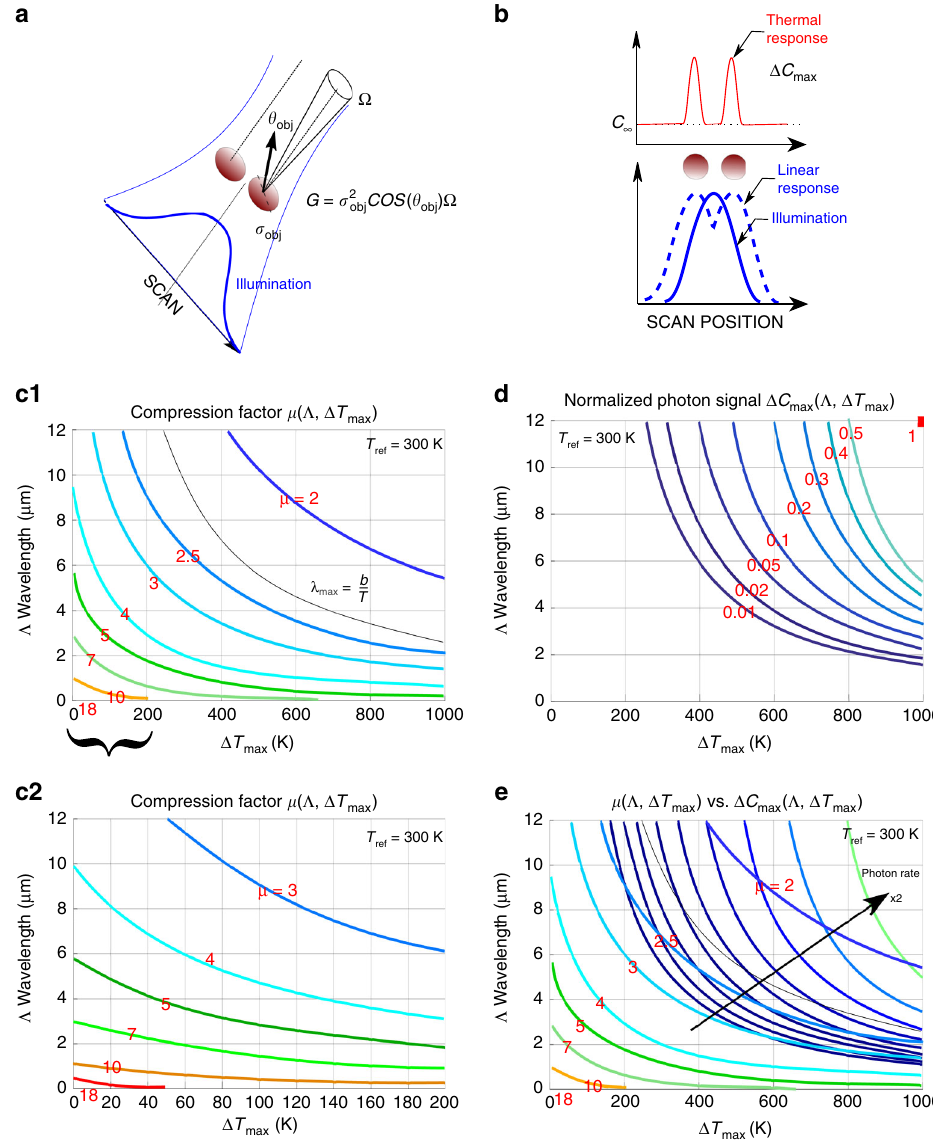
Fig. 3 Scanning illumination, thermal response, and compression factor. a Two supposedly planar objects are illuminated by a focused beam with an excitation psf larger than their linear size σ and the distance between them. Each object has an obliquity angle θ obj G ¼ σ 2 cos ð θ obj Þ Ω . b The Planck thermal photon signal C max produced by the scanning illumination is compared to the linear response. C ref represents the obj background thermal photon signal. c1 , c2 The 2D plot of the psf compression factor μ as a function of the maximum heating Δ T wavelength Λ . μ is computed for a Gaussian illumination psf as the ratio of the FWHM of the illumination psf and the thermal radiation psf, and shown for (cid:6) 1000 K ( c1 ) and 0 K (cid:6) Δ T (cid:6) 200 K ( c2 ). d Biparametric representation of the signal Δ C 0 K (cid:6) Δ T max max Δ C is obtained by integrating the photonic radiance P over the area of the thermal emission psf, and normalized to its value for Δ T max Λ ¼ 12 μ m (top-right corner). e Optimum of the trade-off of the photon budget and the resolution as a function of Δ T , respectively. Each unlabeled line corresponds to a value of Δ C and unlabeled lines represent constant values of μ and Δ C max previous